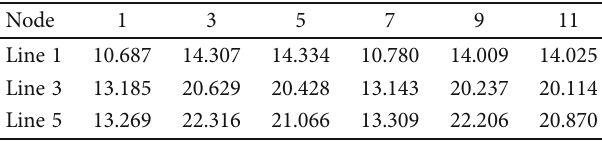
Table 4: Displacement peak of di ff erent nodes under di ff erent